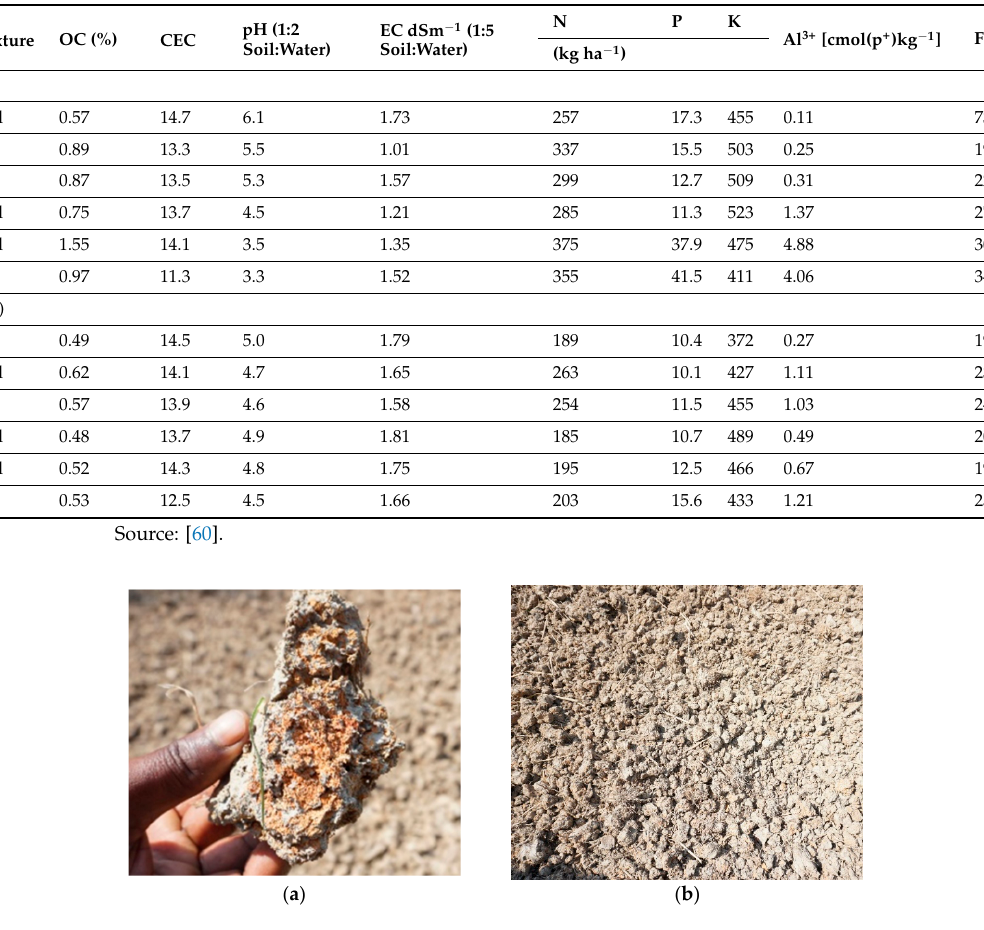
Figure 2. Yellow jarosite mottles found in the plough layers of acid sulphate soils on Sonagaon and Gosaba islands, Sundarbans: ( a ) Soil clods containing mottles; ( b ) Surface-tilled soil layer with abundance of jarosite mottles. Source: Authors’ own collection from Sonagaon village on Gosaba island in the Indian part of the Ganges Delta.